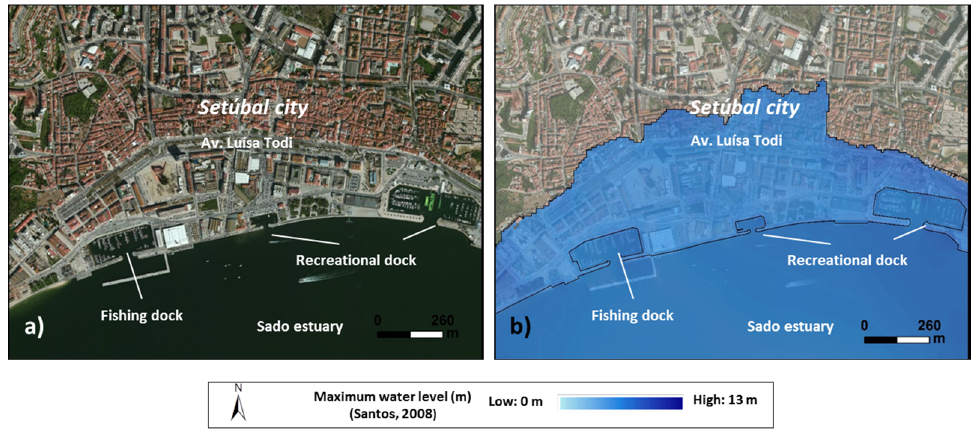
Figure 4. Setúbal study area: ( a ) Satellite image from study area; ( b ) Tsunami inundation from numerical model results for Setúbal [2].